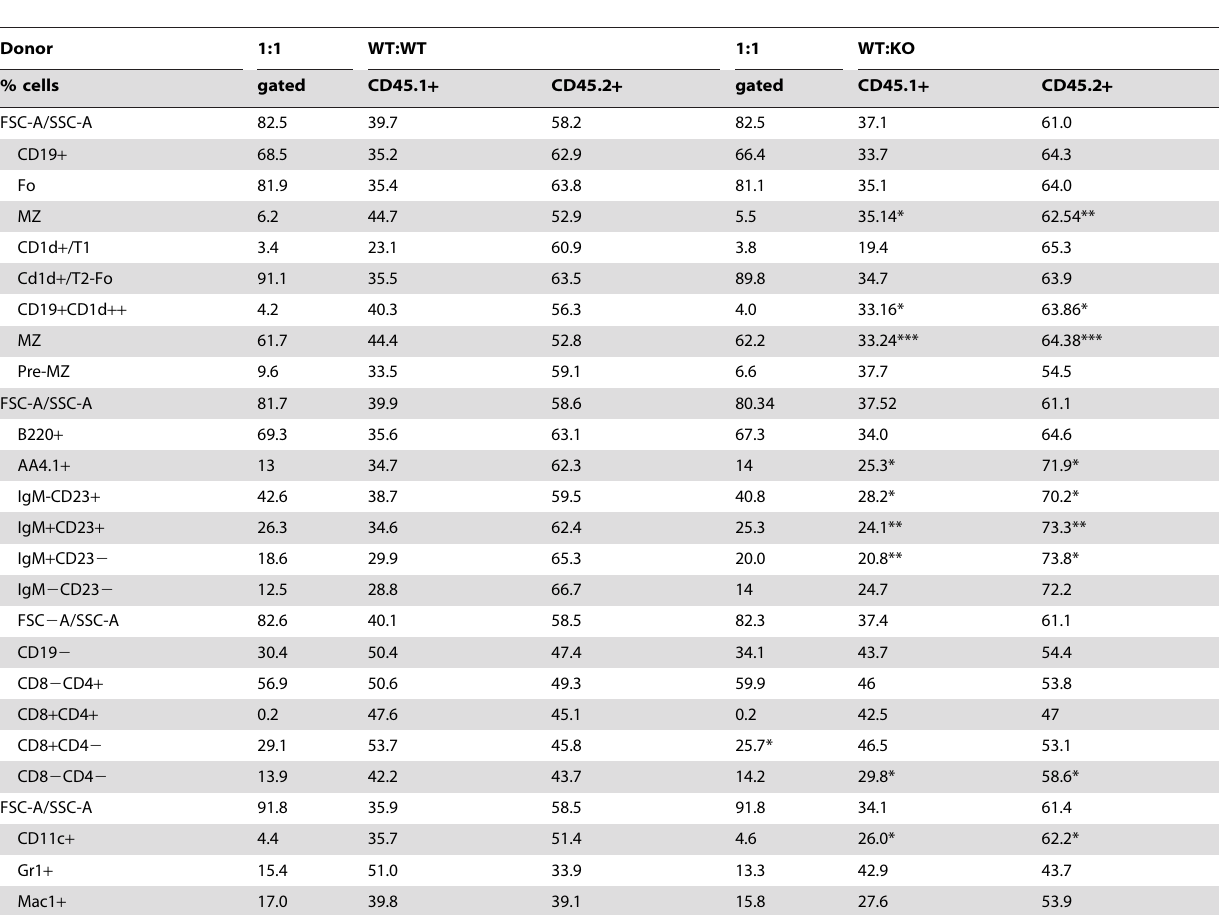
Table 2. FACS analysis of the cellular populations present in the spleen three months after competitive bone marrow transplantation.